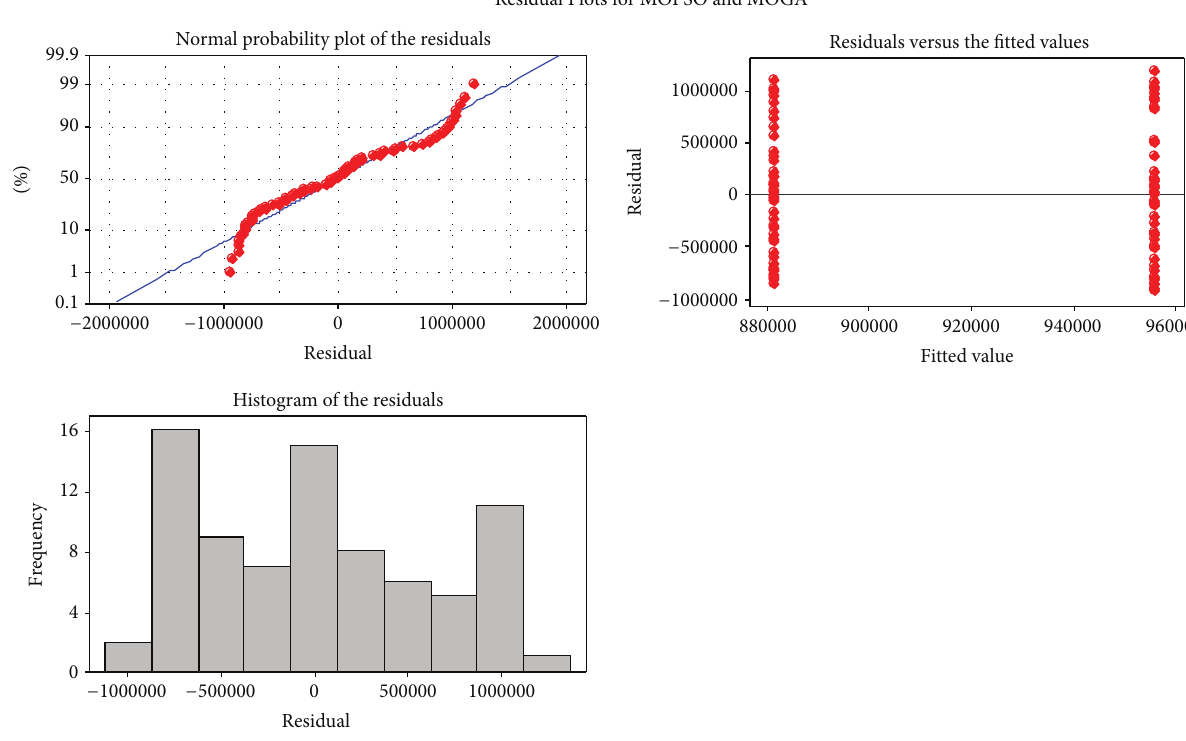
Figure 8: The residual plots of the